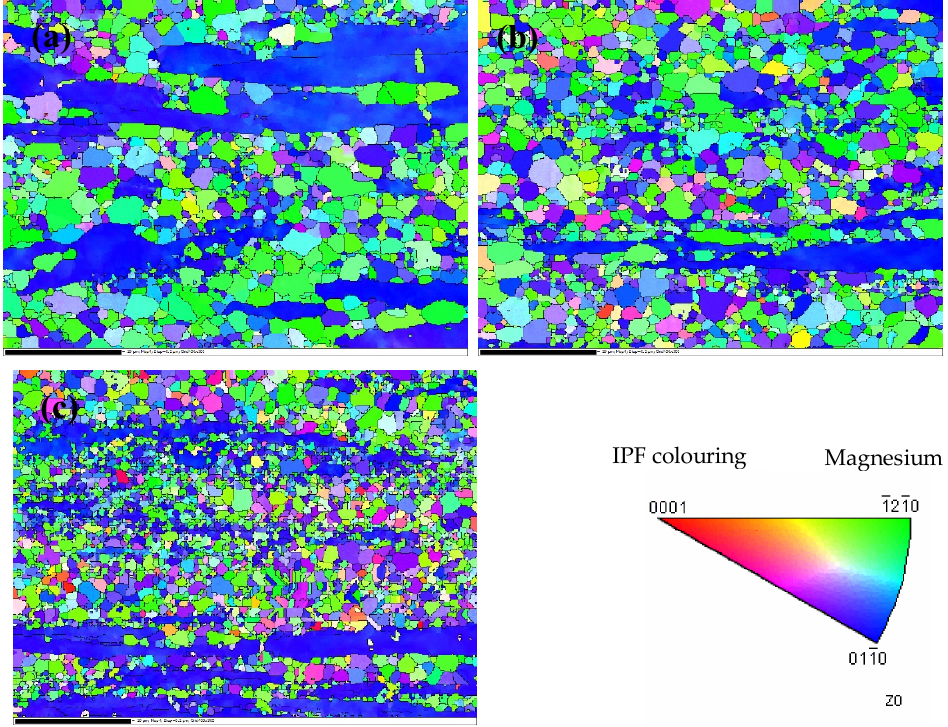
Figure 4. Orientation of the extruded AZ31-xCaO alloys. ( a ) AZ31; ( b ) AZ31-0.5%CaO; and, ( c ) AZ31-1%CaO.